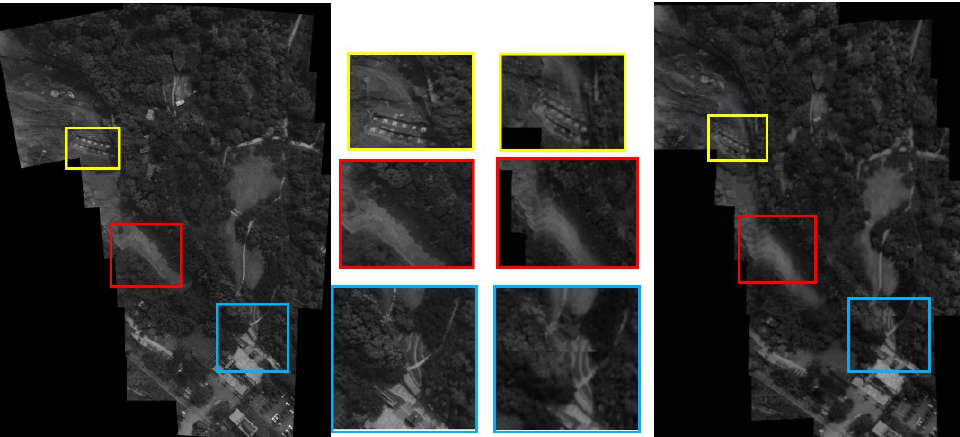
Figure 7. Comparison of the stitching results of the first set of hyperspectral images with the authors’ previous work [34] (single